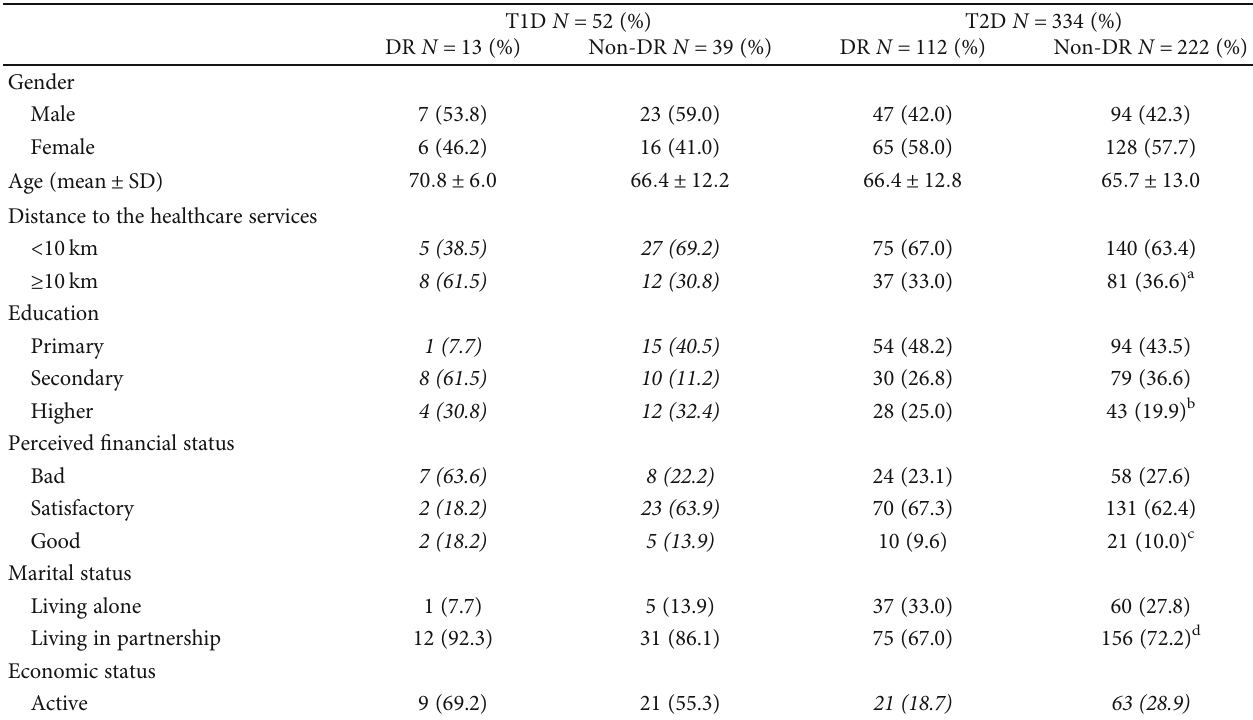
Table 1: Characteristics of the study